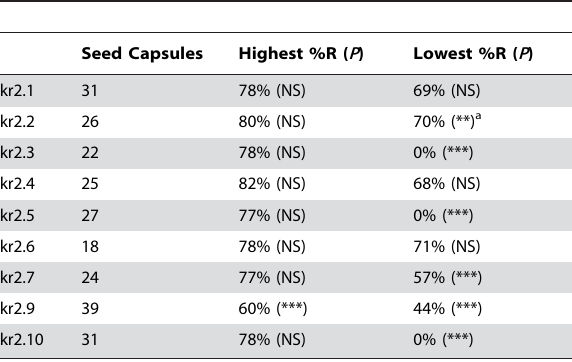
Table 1. Segregation of kanamycin resistance in individual self-fertilised seed capsules of